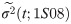
Variance of the trading volume, σ2˜(t;1S08)
v
t.The curve corresponds to semester 7 (1S08) and it was normalised by a factor 108. We use different tones of blue to turn the distinction between the morning and afternoon parts of the session easier.